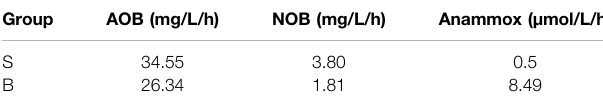
TABLE 2 | Potential activity of AOB, NOB, and anammox in S and B groups.